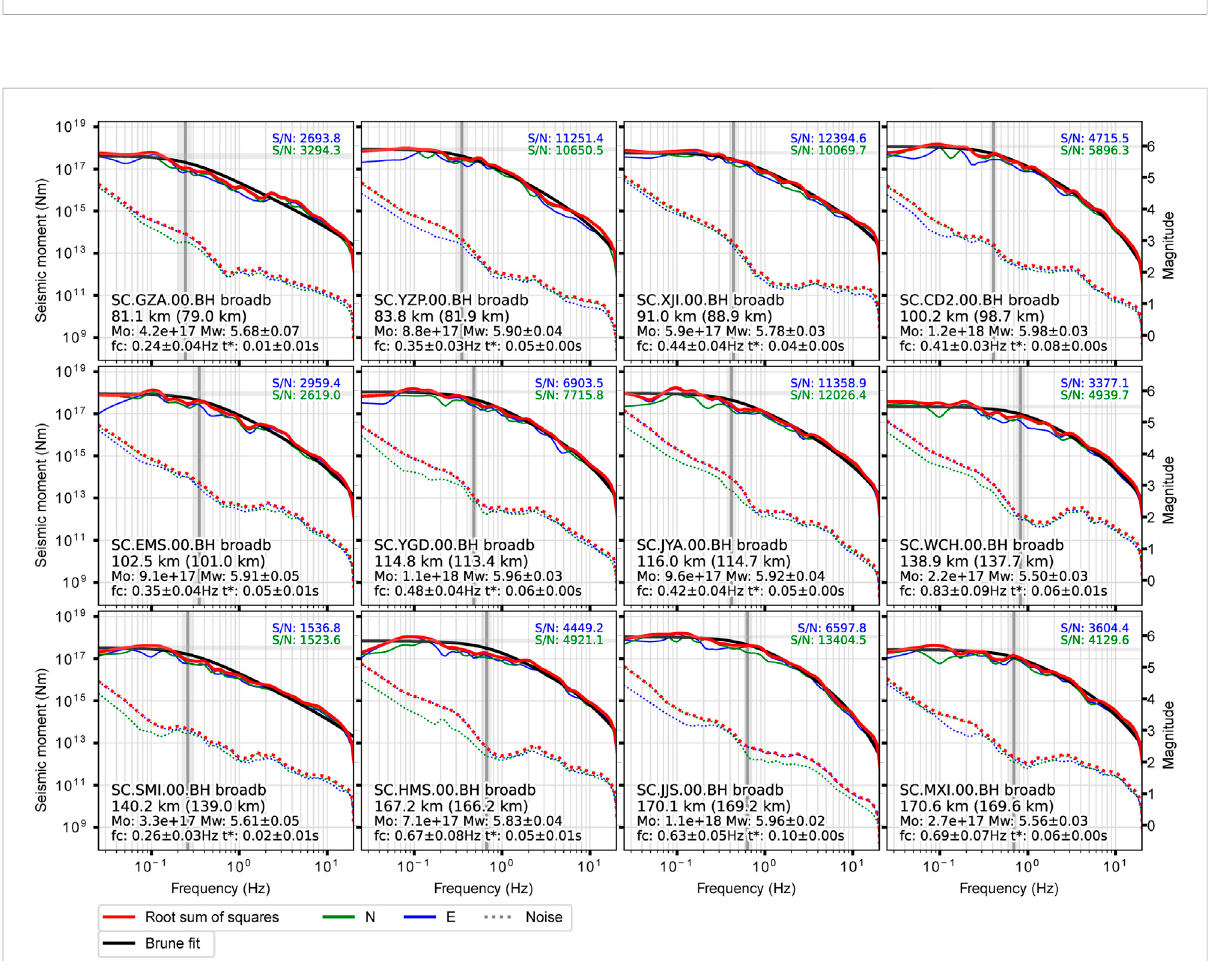
FIGURE 2 Examples of source spectra for a M w = 5.8 event. The black dashed curves show the best fi t ω − 2 model spectra, and the vertical line represents the corner frequency.